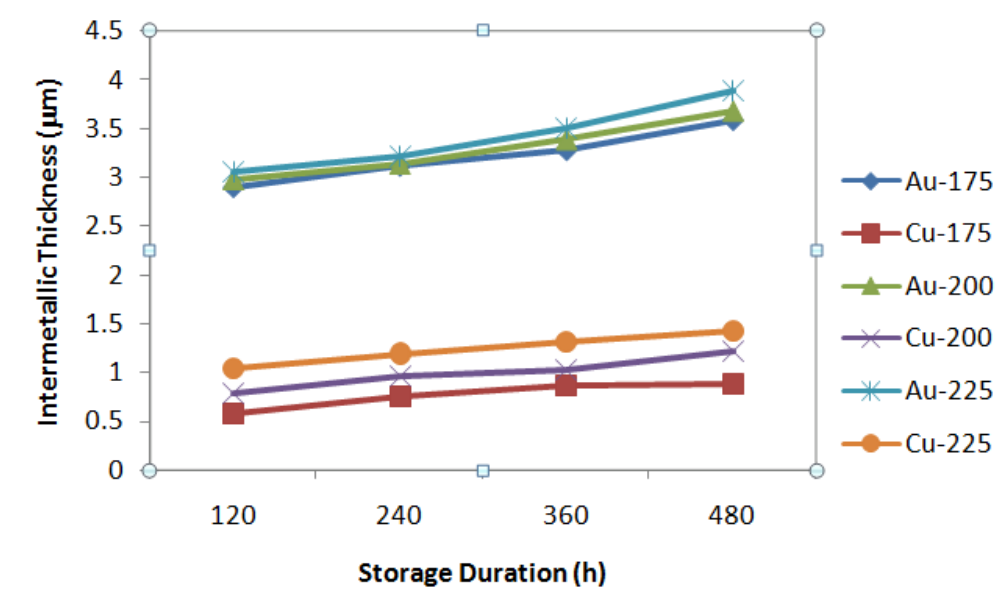
Figure 9. Intermetallics measurement at different HTS